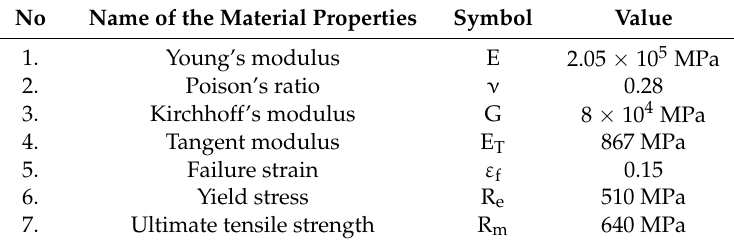
Table 2. Material